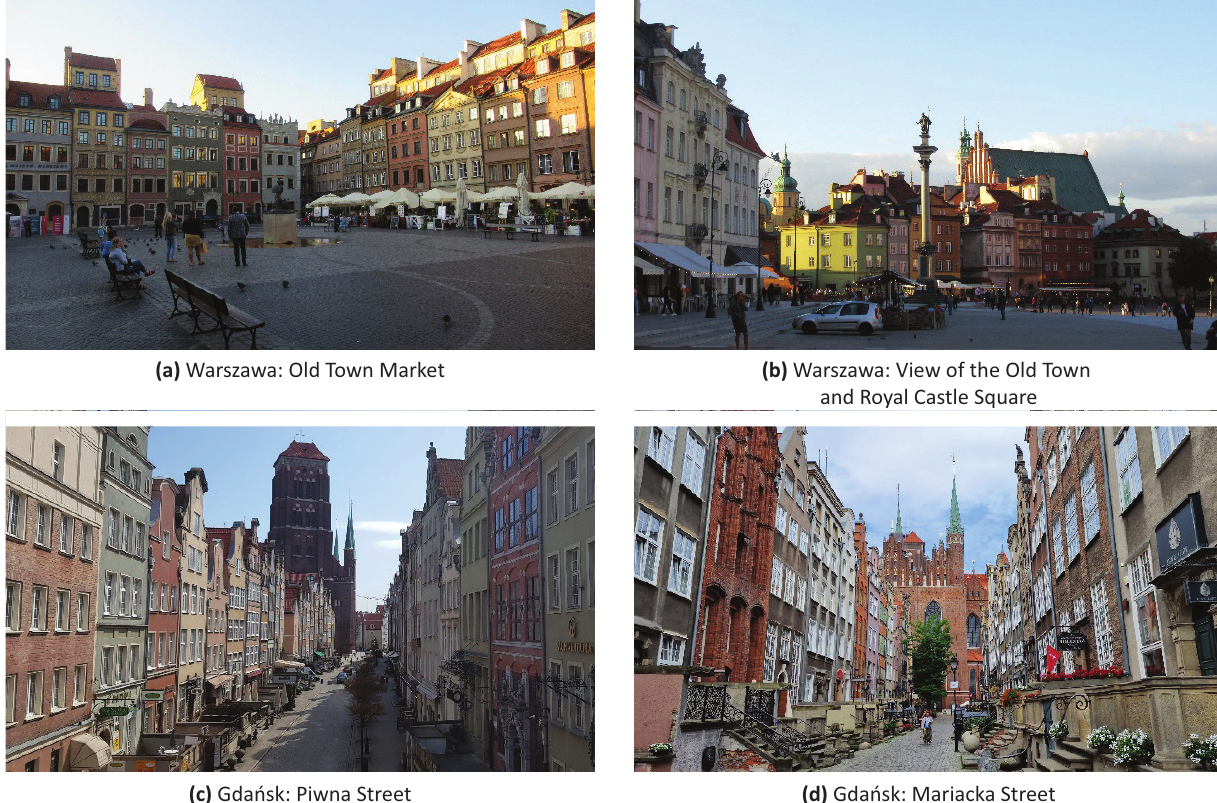
Figure 2. Selected examples of the structures rebuilt according to the rules of the Polish School of Conservation. Urban Planning, 2023, Volume 8, Issue 1, Pages